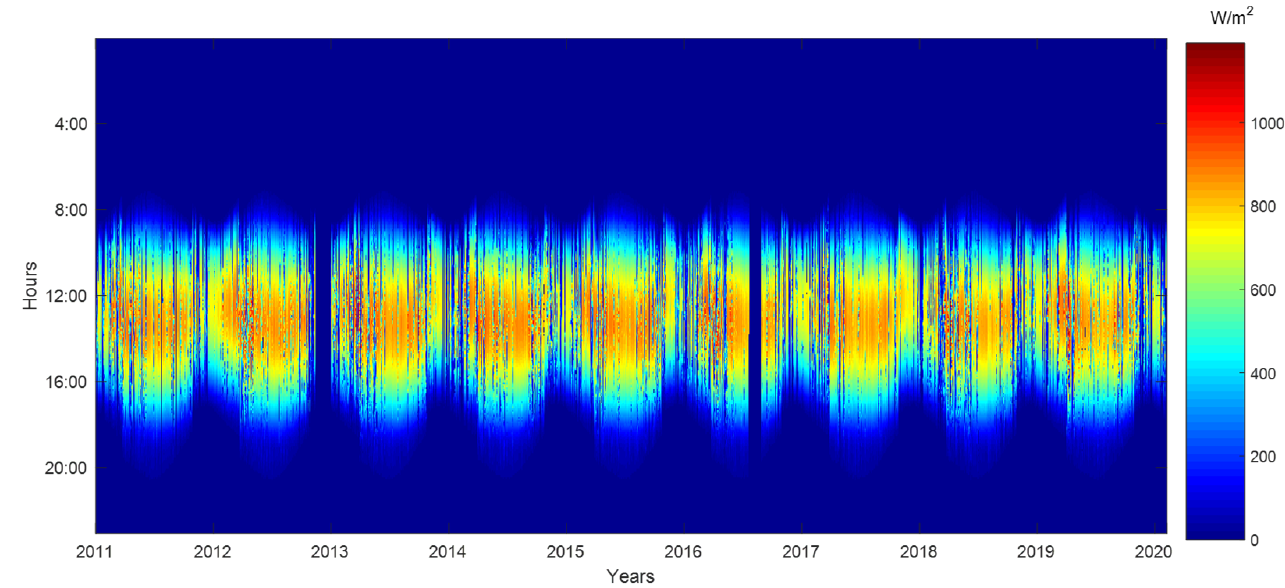
Figure 1. Instantaneous in-plane irradiance values registered from 2011 to 2020 with a frequency sample of 5 min. Figure 2 shows a histogram in which the total daily irradiance values for each of the days shown in Figure 1 can be observed. It can be seen that, influenced by the greater or lesser number of daily hours of sunshine throughout the year, and by the meteorological conditions, the total daily irradiance received by the panels in the geographical location analysed in this work can vary from values of less than 10 to values greater than 80 kW/m 2 per day. The red dashed lines show the values of total daily irradiance received by the panels that were obtained by the k-means algorithm to classify the analysed days in the three types named low (L), medium (M) and high